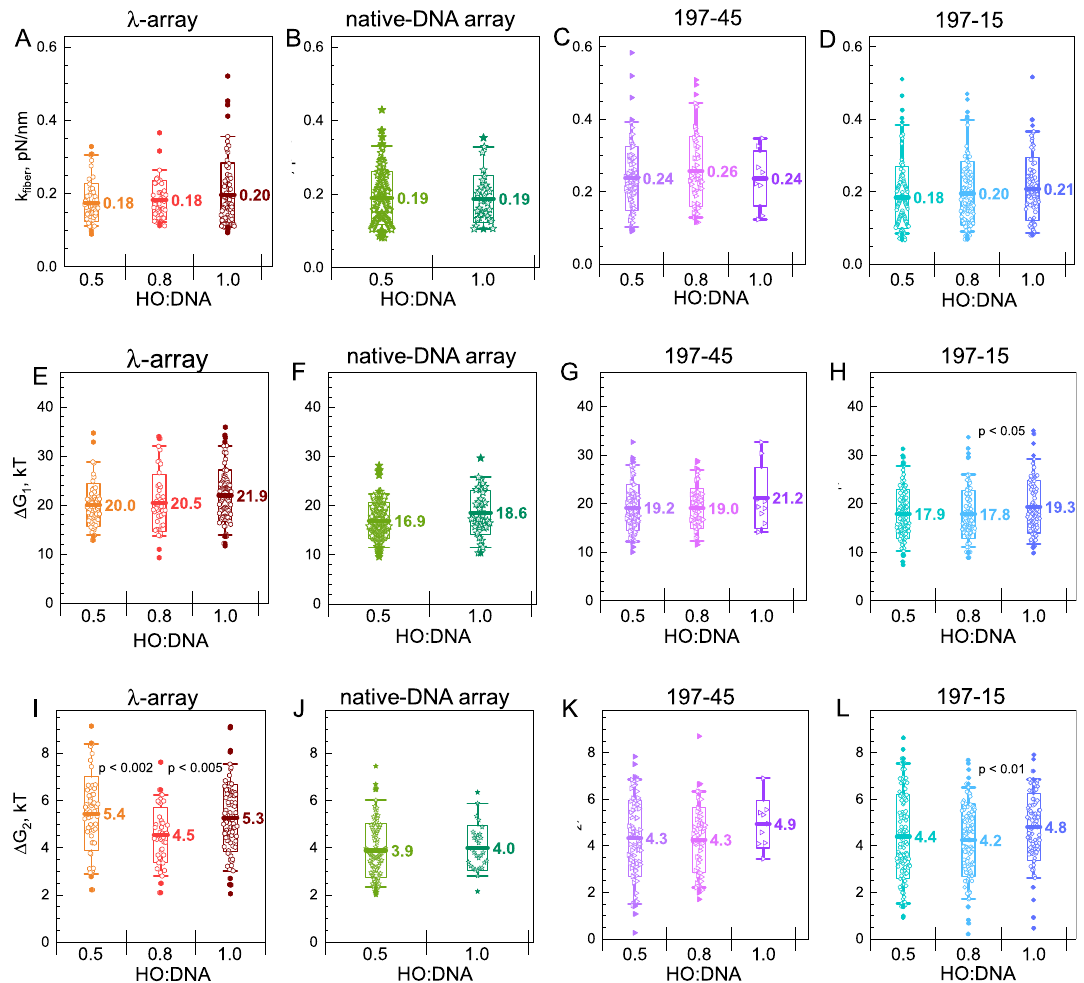
Figure 6. Mechanical properties of the λ-arrays, arrays reconstituted on the MNase-digested genomic DNA, positioned 197 bp NRL arrays obtained for different HO:DNA ratios by fitting experimental data to the statistical mechanics model. ( A – D ) stiffness ( k fiber ) of the folded arrays; ( E – H ) free energy of the nucleosome folding and unwinding of the first 53 bp of the DNA from the histone core ( ∆G 1 ); ( I – L ) free energy of the further unwinding of the 13 bp DNA ( ∆G 2 ). The left columns ( A , E , I ) is the data for the λ-arrays; second, the left column ( B , F , J ) is for the native DNA arrays; second, the right column ( C , G , K ) is for the 197-45 arrays; and the right column ( D , H , L ) is for the 197-15 arrays. In the graphs, thick lines with labels indicate the mean; boxes show the range within mean ± sd; whiskers show a 5–95% range of data; solid points indicate outliers. OriginPro software 75 (http:// www. origi nlab. com) was used to create the